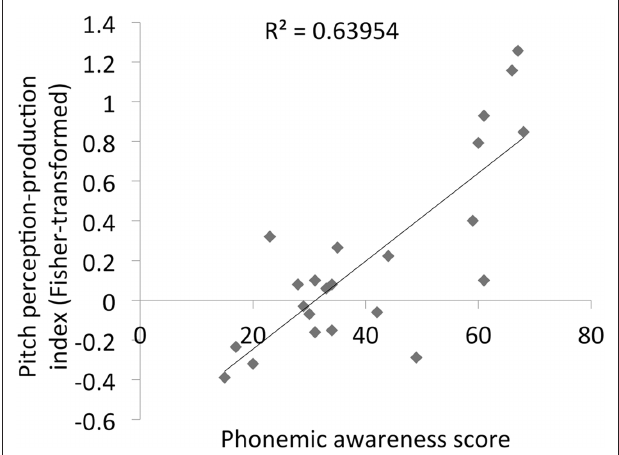
Figure 1 | Pitch perception–production index as a function of phonemic awareness score.